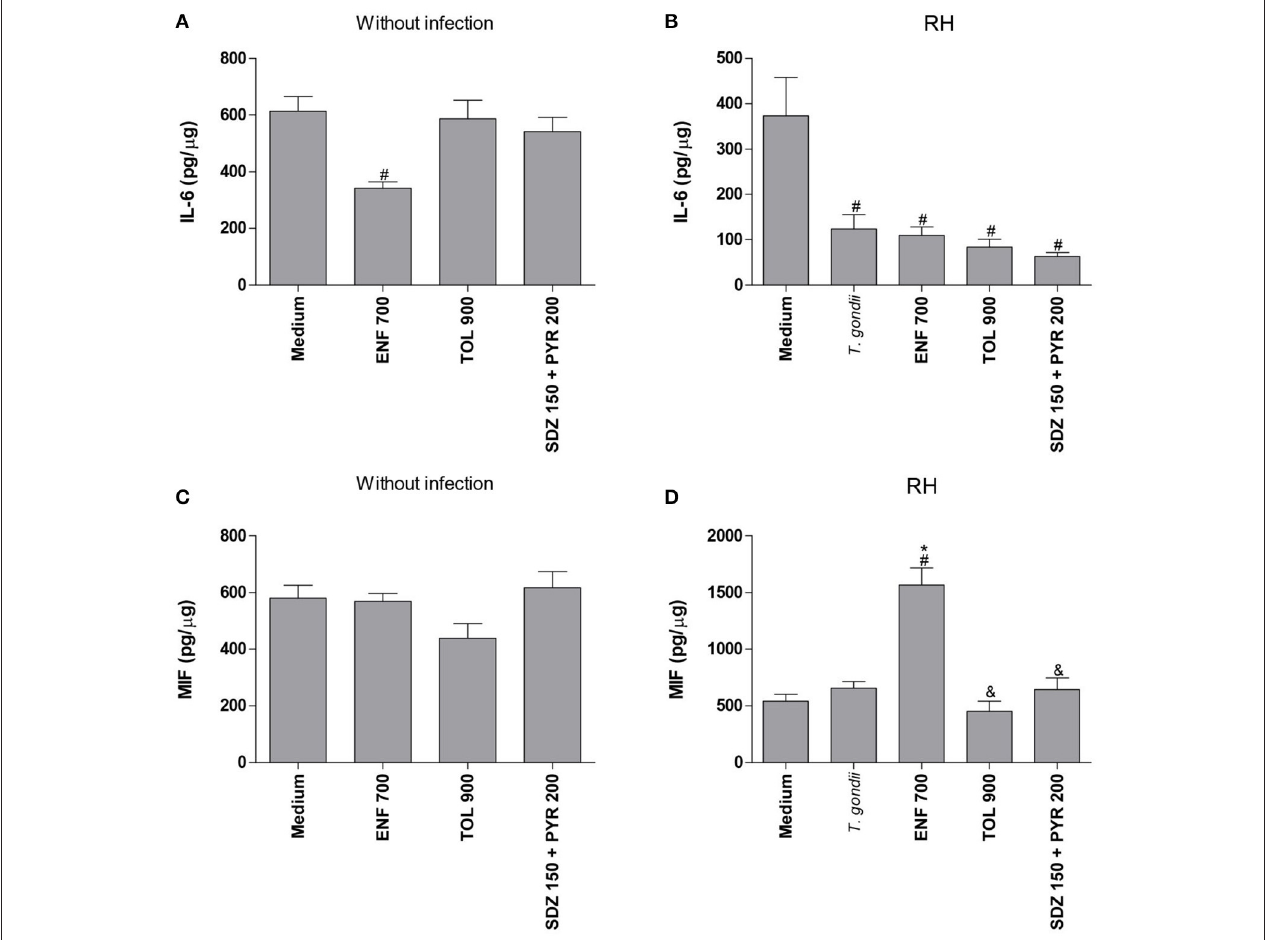
FIGURE 7 | Cytokines production in human villous explants treated with different drugs and infected by T. gondii . Villous explants were collected and cultured during 24h, infected or not with T. gondii (RH-2F1 clone), and after 24h were treated or not with the different drugs ( µ g/mL): enrofloxacin (ENF), toltrazuril (TOL) or combination of sulfadiazine and pyrimethamine (SDZ + PYR) for additional 24h.The supernatants were collected for detection of IL-6 (A,B) and MIF (C,D) . Data were expressed in pg/ µ g according to the protein concentration of each villous and the standard curve. Data were expressed as mean ± SEM of three independent experiments in nine replicates. Significant difference in relation to untreated and uninfected villous (medium) ( # P < 0.05), untreated and infected villous ( T. gondii ) ( ∗ P < 0.05), and ENF ( & P < 0.05). Differences between groups were analyzed by One-Way ANOVA with the Bonferroni multiple comparison post-hoc test.